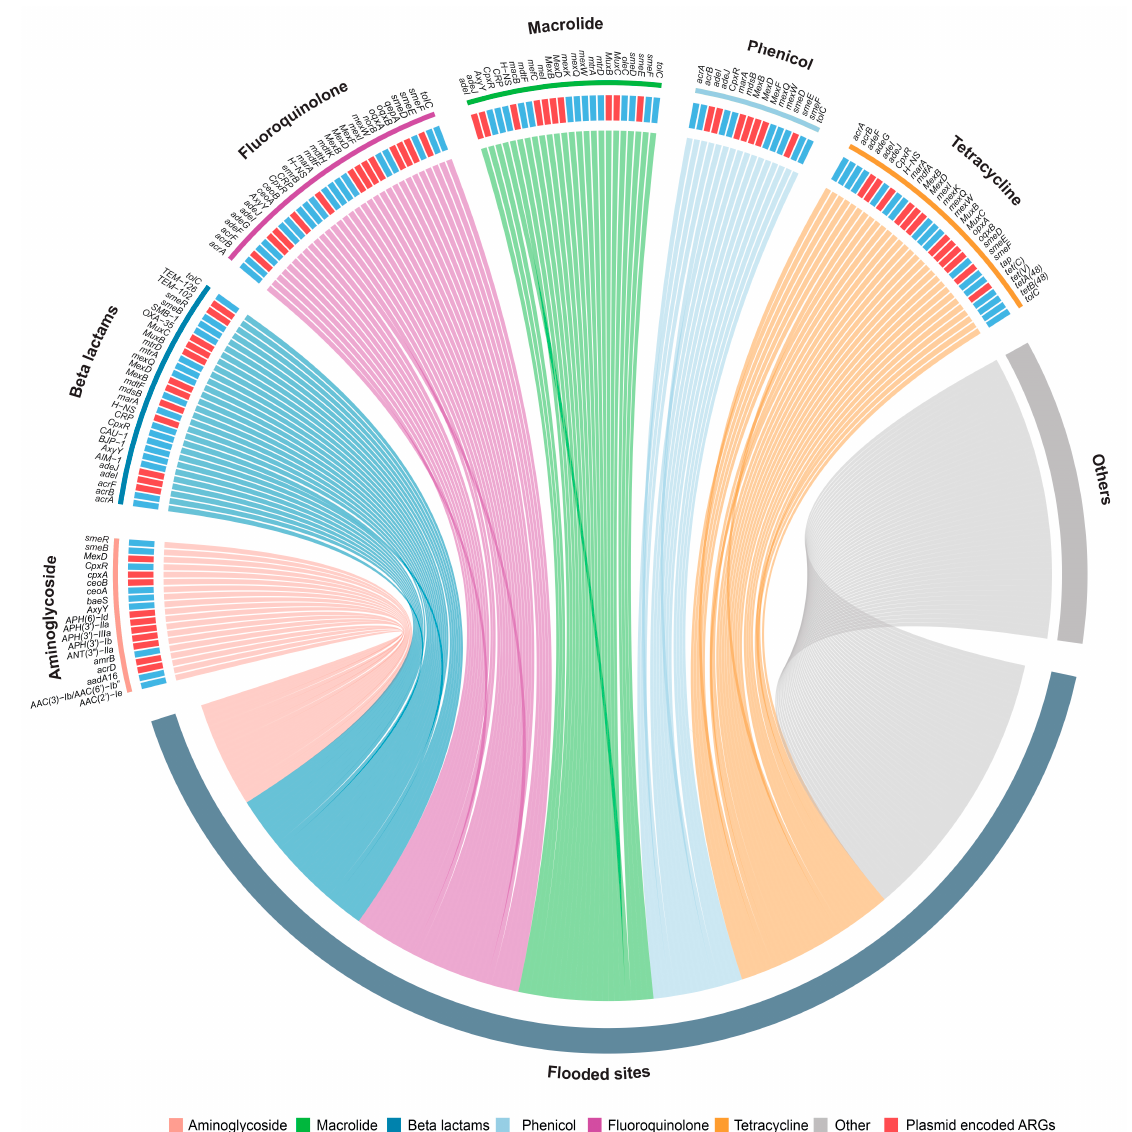
Figure 2. Resistome of the flooded sites. Chord diagram showing the presence of Antibiotic Resistance Genes (ARGs) detected in flooded sites. ARGs in flooded sites were classified into 6 major drug classes. The coloured edges represent the proportion of ARGs of different drug classes detected in flooded sites. ARGs conferring resistance to aminocoumarin, sulfonamide, mupirocin, rifampicin, triclosan, glycopeptide and diaminopyrimidine classes of antibiotics are represented as others category. Red blocks indicate plasmid-encoded ARGs. A complete list of antibiotic resistance genes and their characteristics are listed in Table S4.